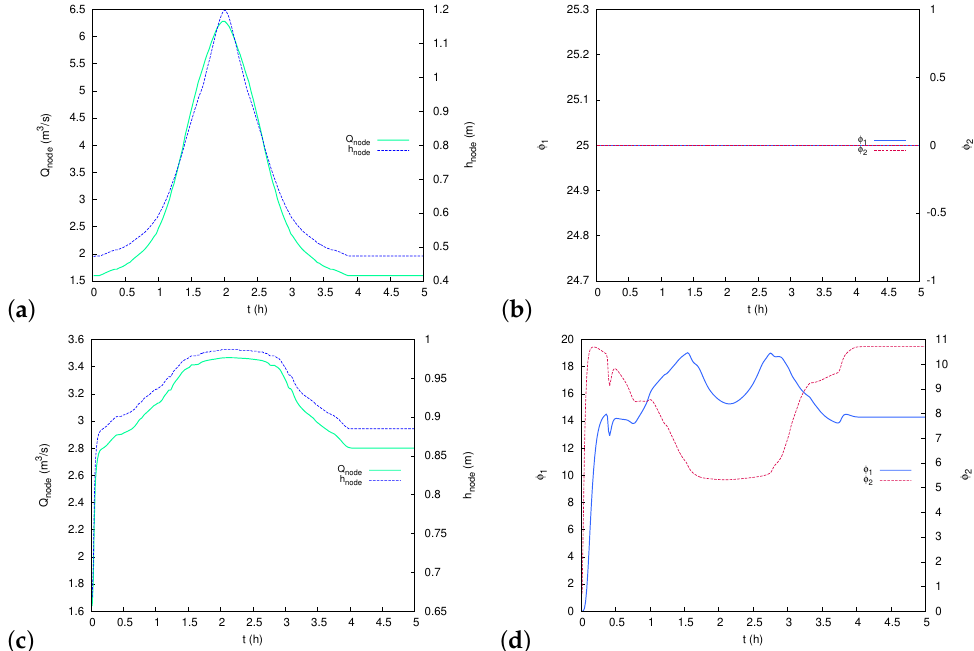
Figure 7. Case 1: Temporal evolution of sewer water depth ( a , c ) and pollutant concentrations ( b , d ) at the inflow point P1 ( upper ) and at the sewer outlet O1 ( lower ),